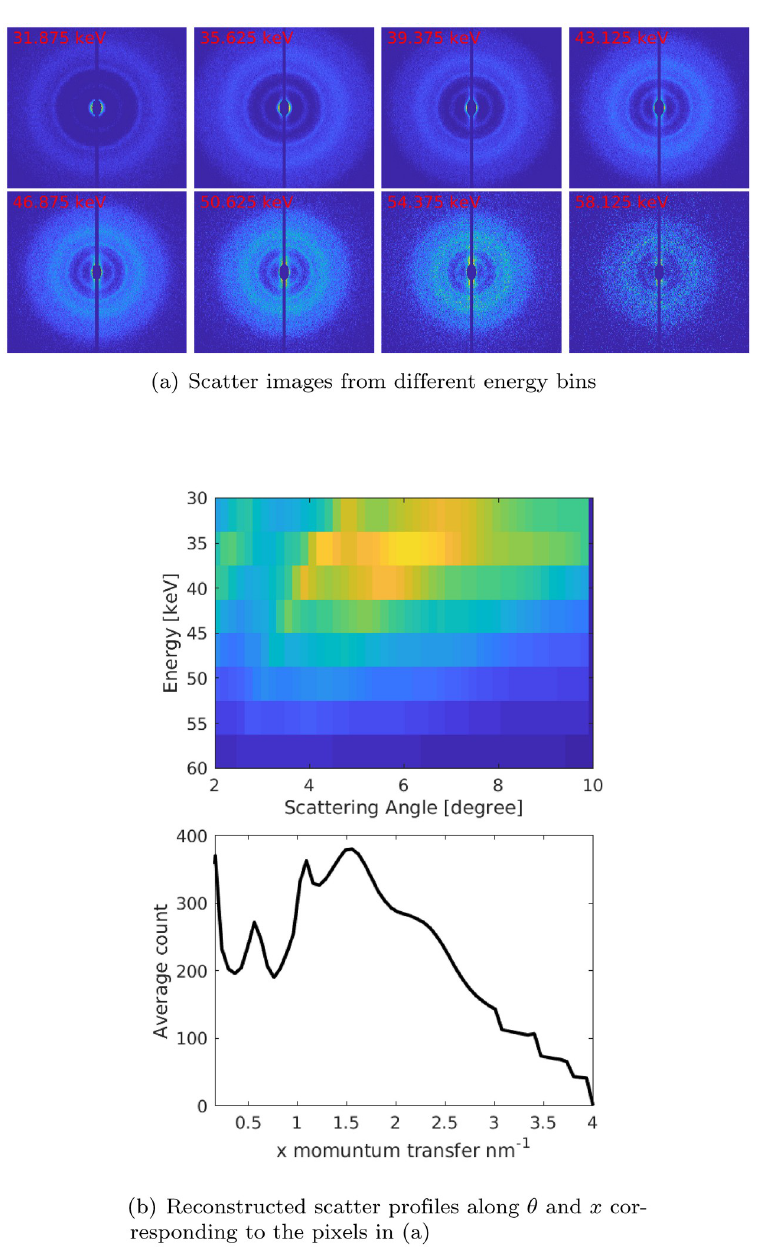
Fig 3. (a) X-ray coherent scatter images acquired from amyloid phantom of 5 mm diameter and x-rays generated at 60 kV. (b) Top row: energy-angle diagram, the z -axis shows the number of counts recorded. Bottom row: x -calibrated spectrum after converting the energy scale into momentum transfer ( x ) scale as described in the